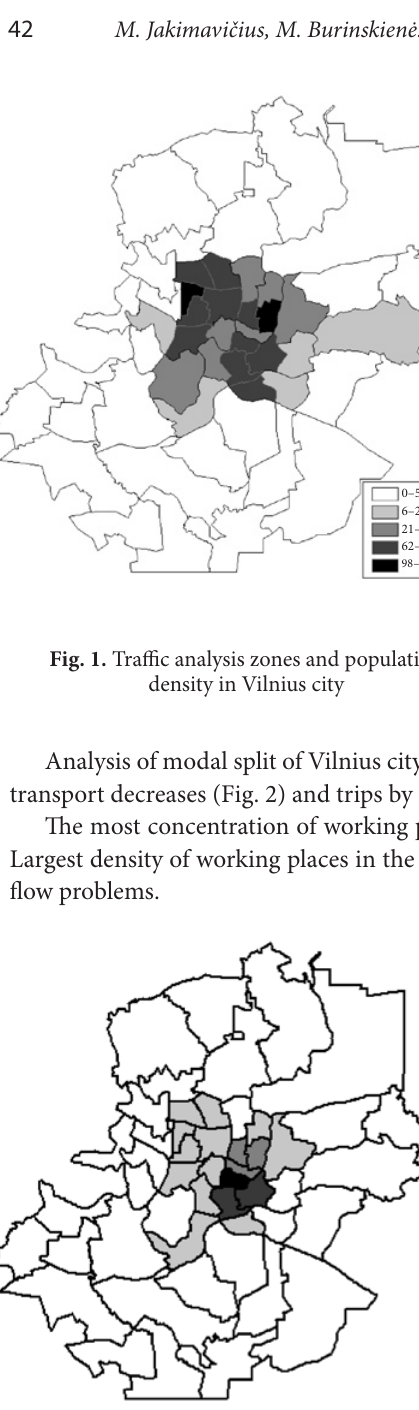
fig. 3. Working places density in Vilnius